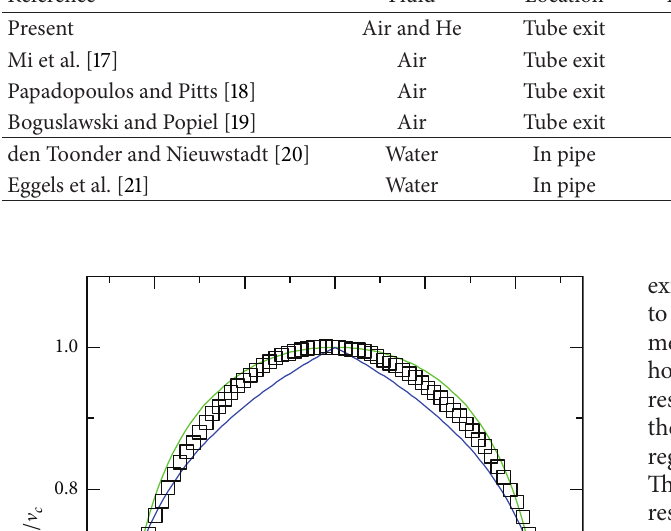
Table 2: Flow properties for the jet exit and pipe measurements from selected references used to compare with the present experiments. Reference